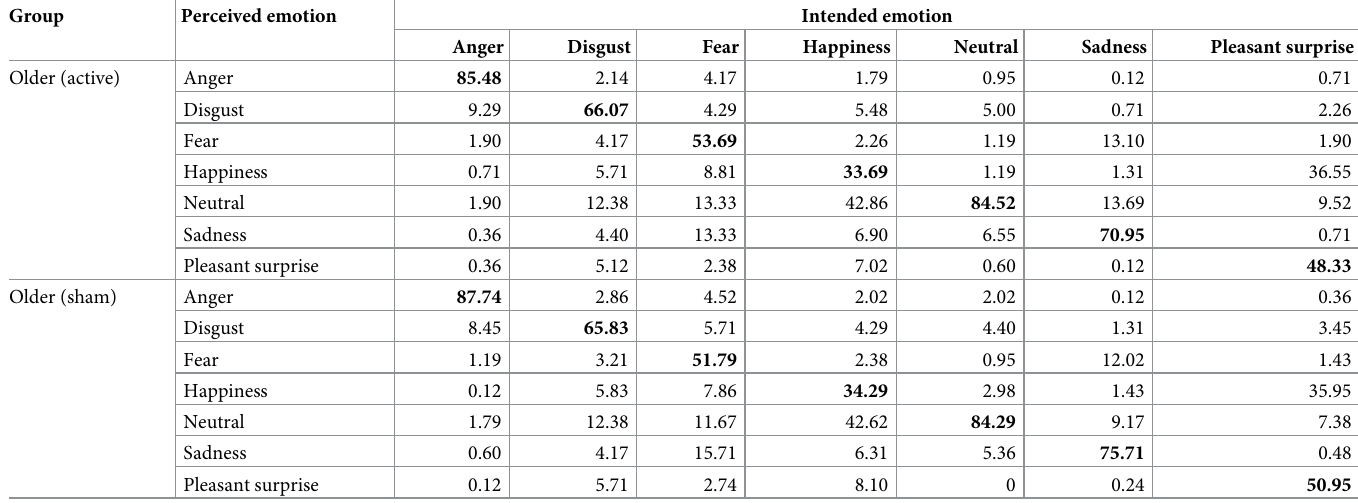
Table 2. Confusion matrix displaying patterns of average response accuracy (in %) per emotion category, per tDCS condition (active, sham), for older